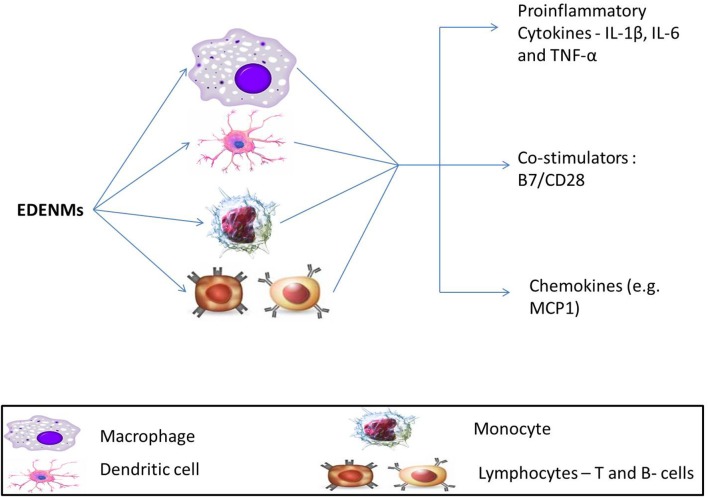
Effect of EDENM on various immune cells resulting in enhancement of expression of various pro-inflammatory cytokines (Interleukins, IL-1β, IL-6; TNF-α, Tumor Necrosis Factor-α), immunoglobulin superfamily members—B7/CD28 and chemokines (MCP-1, Monocyte chemoattractant protein-1).